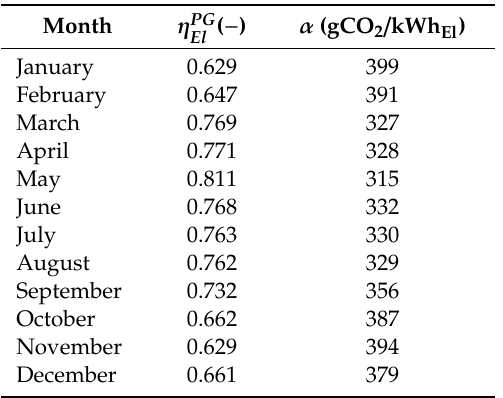
Table 5. Average monthly values of η PG